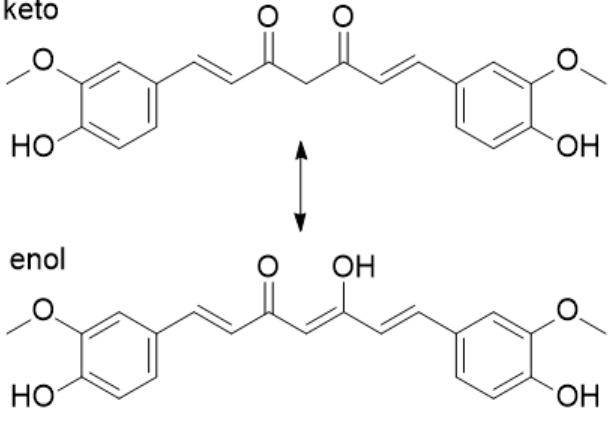
Figure 2. The keto–enol tautomerism of curcumin.